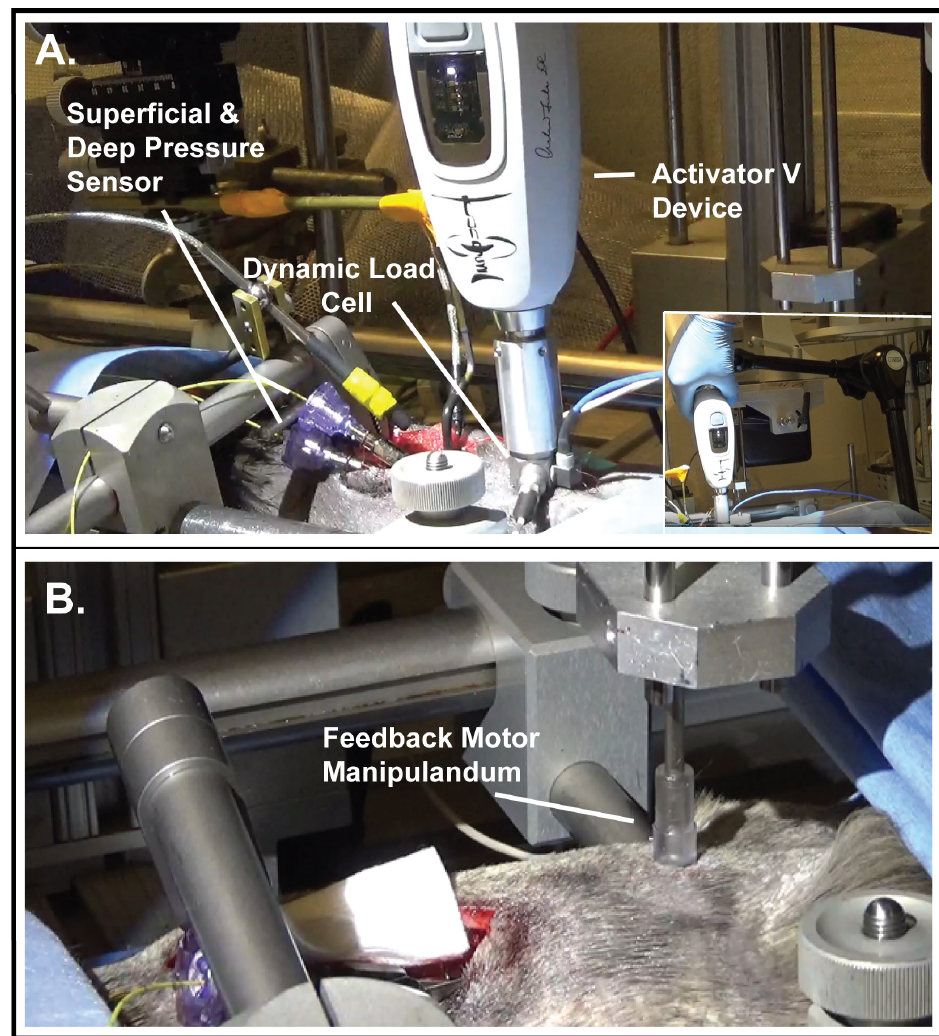
Figure 1. Experimental set-up. Photographs of ( A ) Activator V device with inset showing device being held by Noga articulated holder with the experimenter’s hand used only to trigger the device, ( B ) Feedback motor manipulandum (tip).